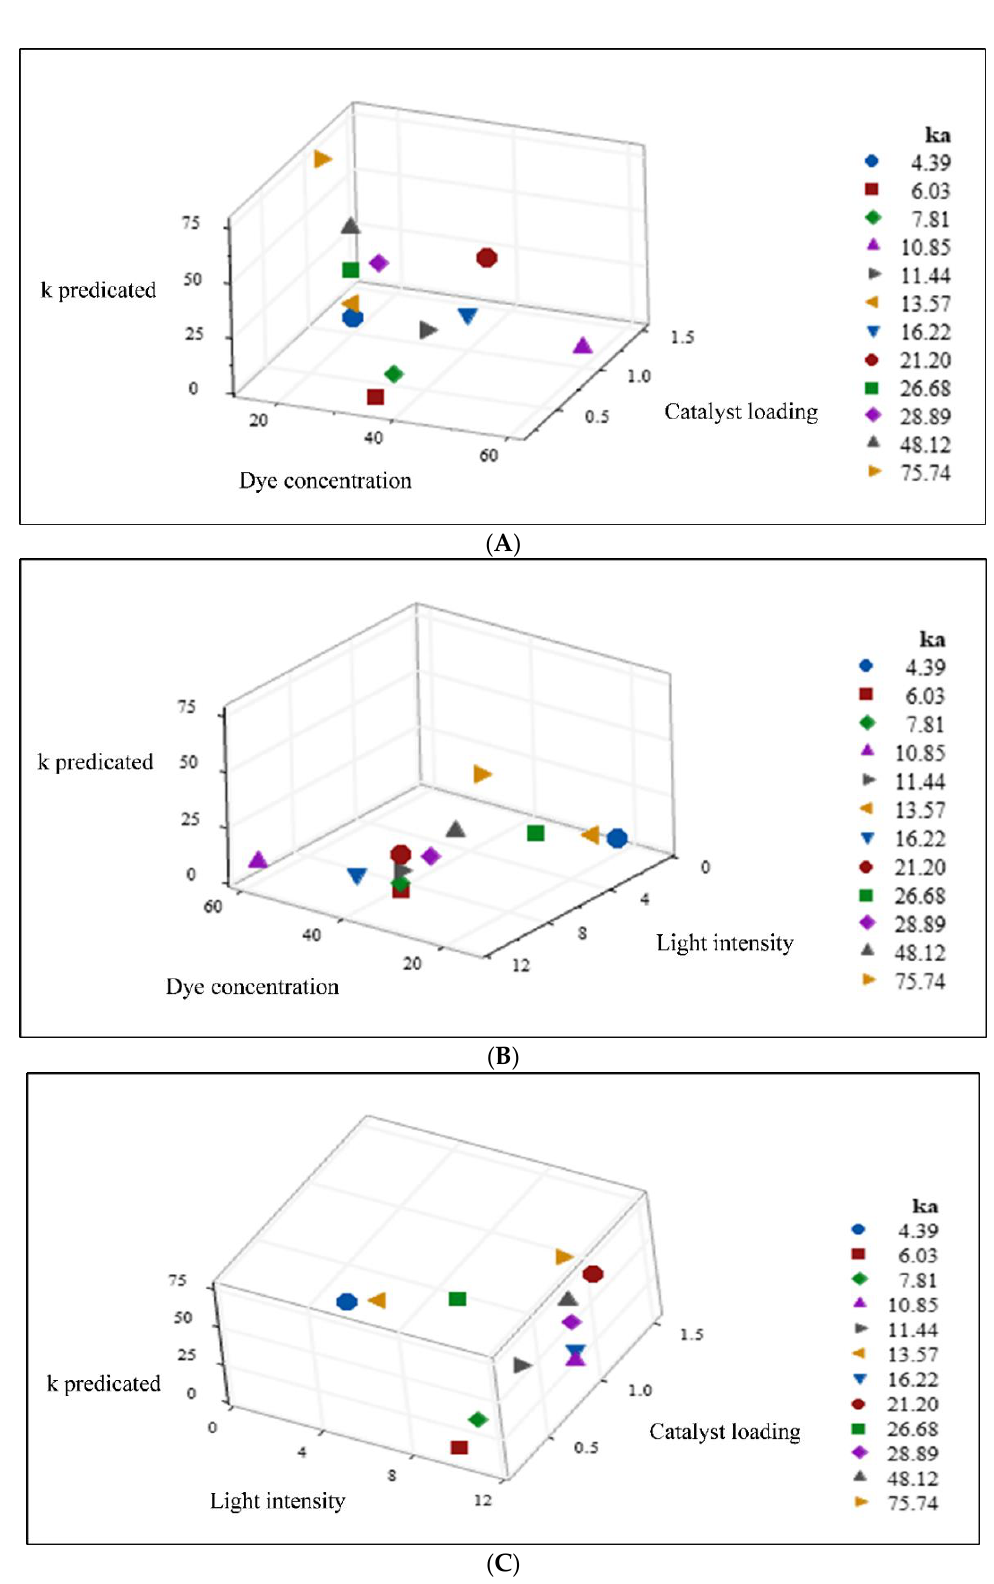
Figure 13. ( A ) 3D Scatterplot of predicted k a values obtained by the empirical model vs. dye concentration and catalyst loading. ( B ) 3D Scatterplot of predicted k a obtained by the empirical model vs. dye concentration and light intensity. ( C ) 3D Scatterplot of predicted k a obtained by the empirical model vs. light intensity and catalyst